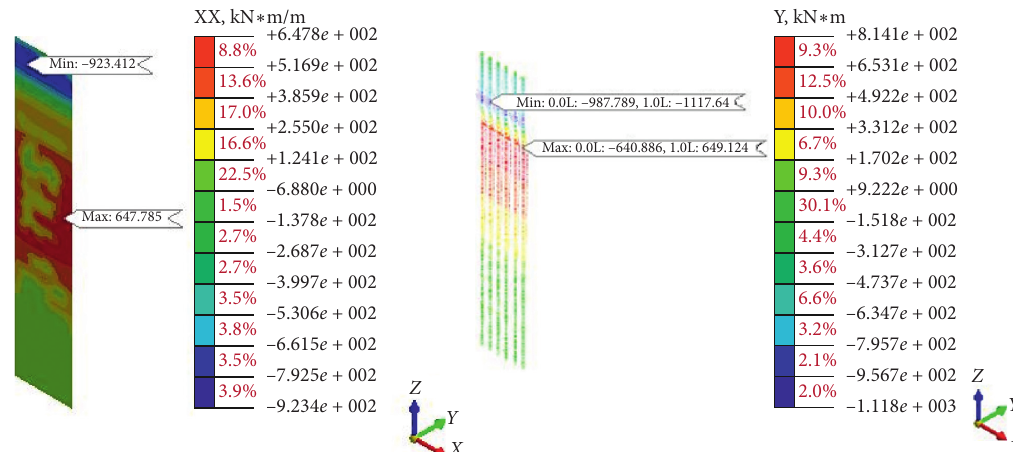
Figure 20: Bending moment per meter of the supporting structure after excavation of wharf (unit: kN ·